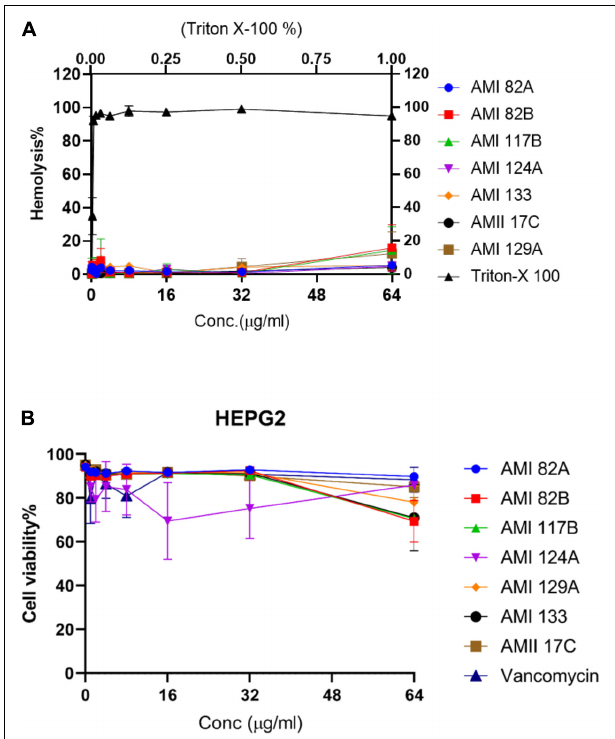
FIGURE 5 | Cytotoxicity for lead compounds. Hemolysis (A) was tested in human erythrocytes and viability (B) was assessed with HepG2